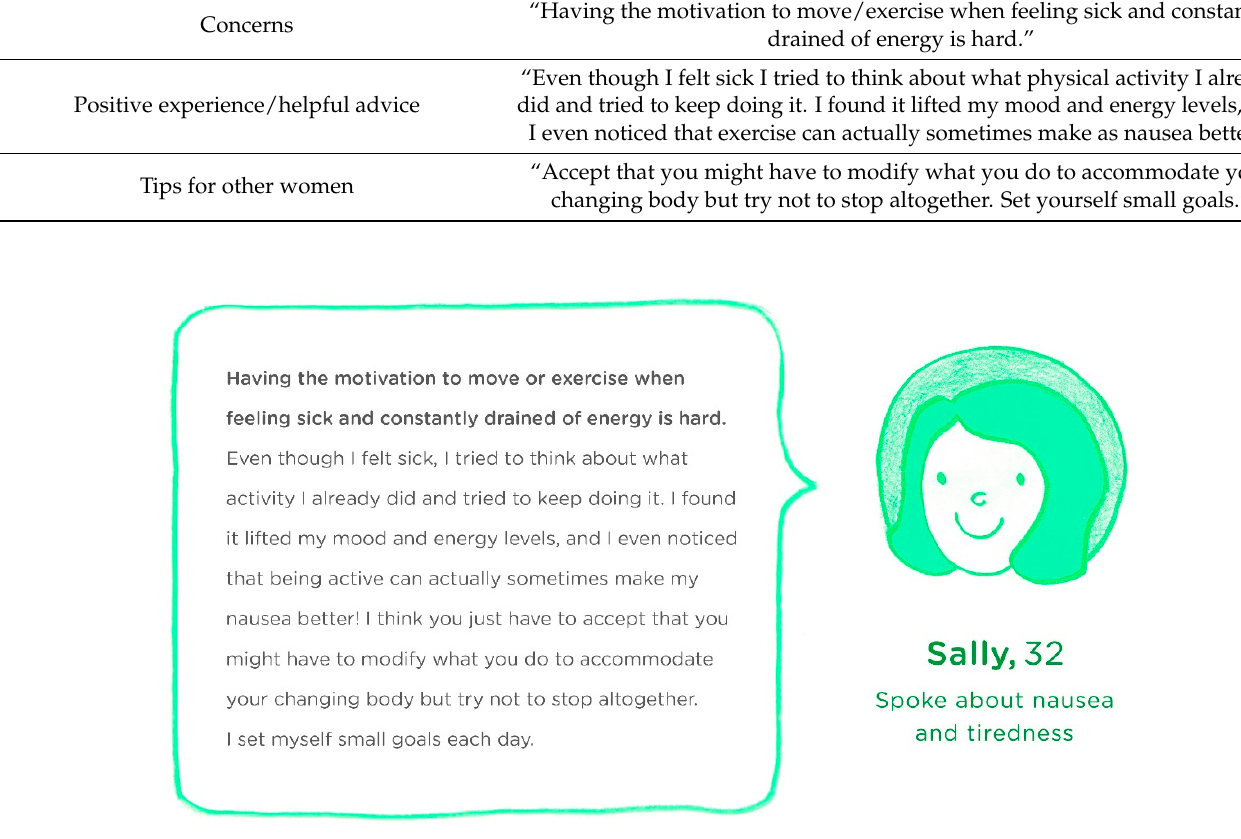
Figure 2. Example illustrated ‘like me’ story relating to nausea and fatigue.